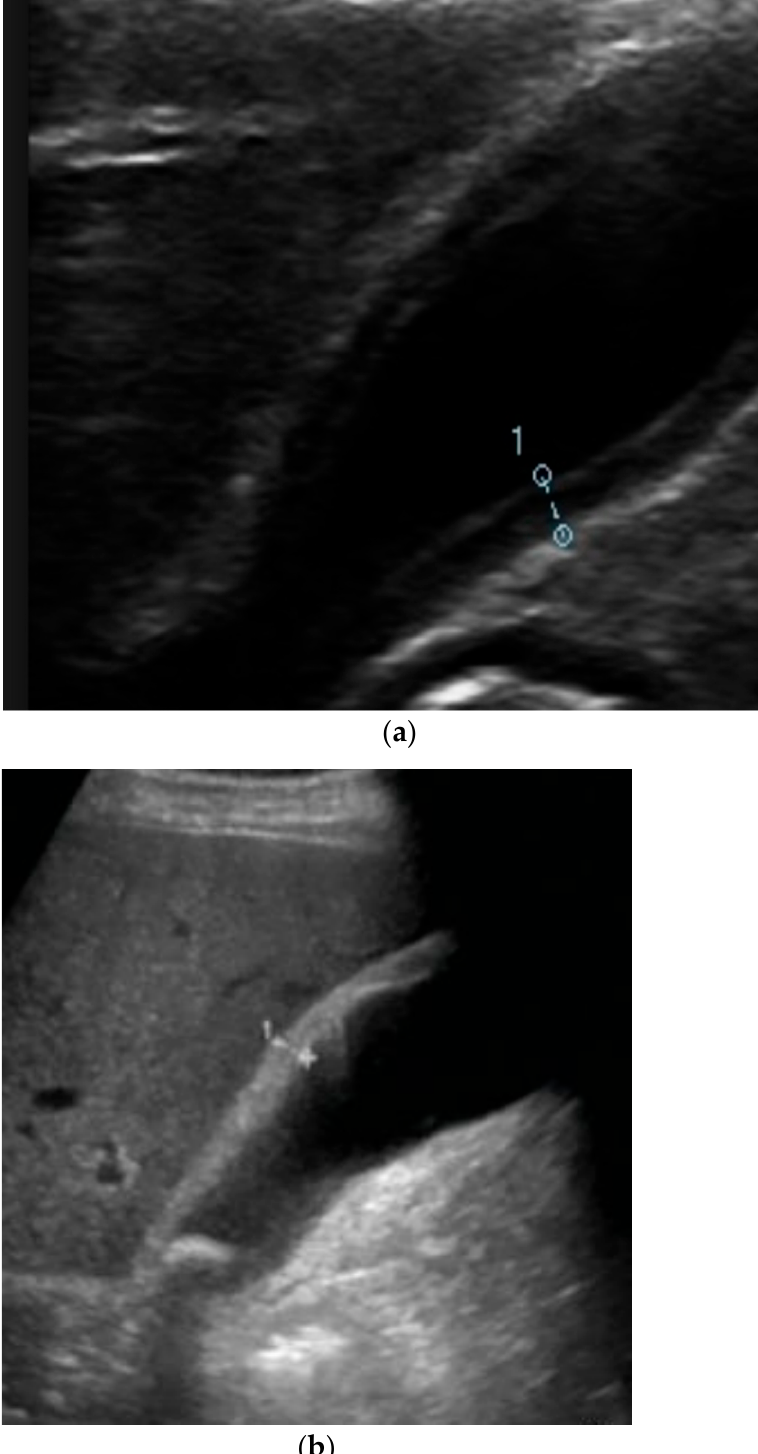
Figure 1. ( a , b ). Thickened-wall gallbladder with “Rail-like” feature, containing minimal biliary sludge mixed with a 7 mm calcinotonic formation at the infundibulum. Pigmentary brown stones are soft, greasy, and are mainly composed of bilirubinate and fatty acids, such as calcium palmitate or calcium stearate [15,16]. They form during infection, inflammation, and parasitic infestation, including that of liver flukes in